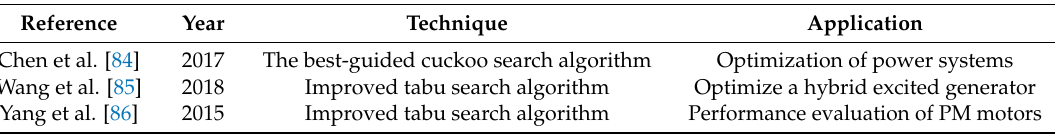
Table 7. Tabu and cuckoo search